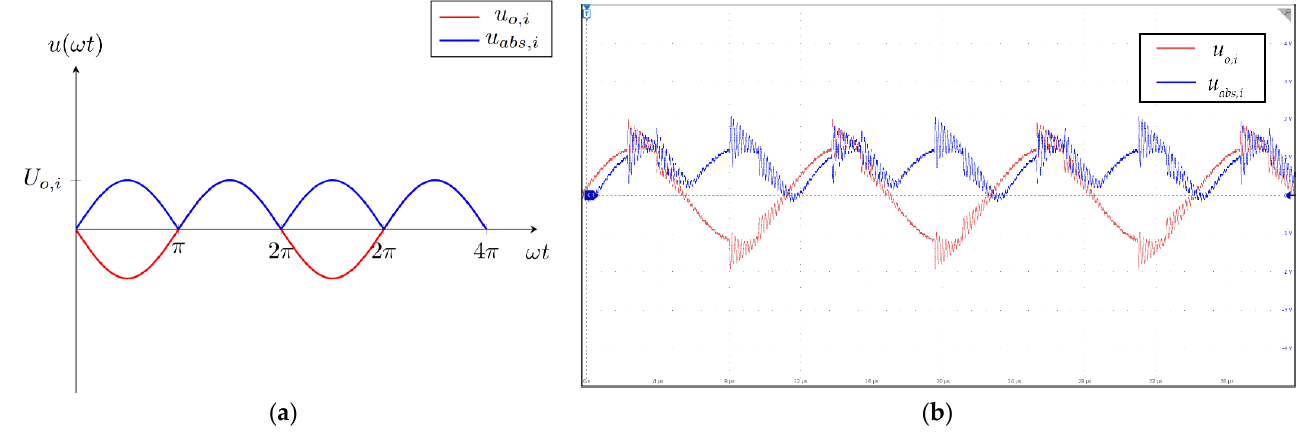
Figure 8. Input and output voltages of the second stage of the measurement circuit: ( a ) theoretical waveforms; ( b ) waveforms measured on the measurement system.